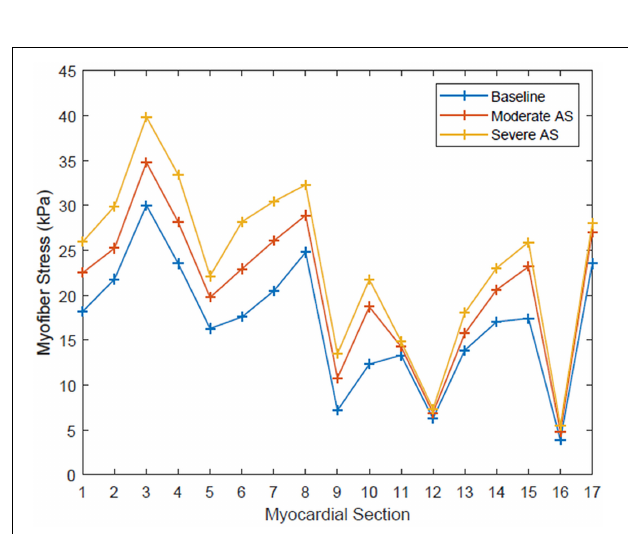
FIGURE 3 | Systolic myofiber stress for each of the 17 standardized myocardial regions for each simulation condition: baseline, moderate aortic stenosis, and severe aortic